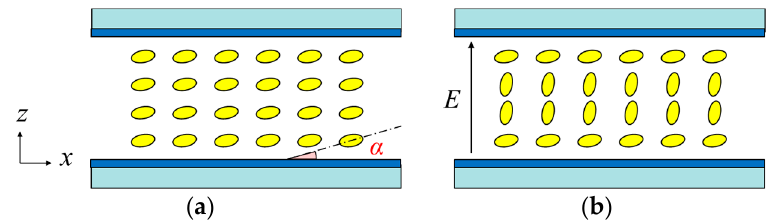
Figure 5. The LC director orientations in the HG mode: ( a ) Voltage-off state; ( b ) Voltage-on state.